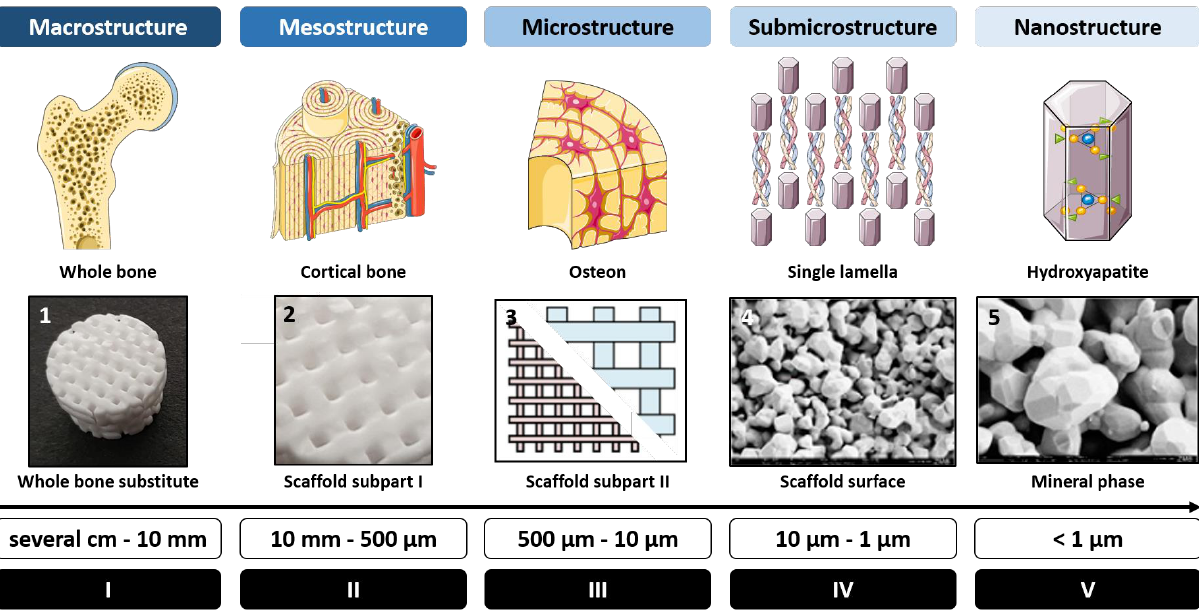
Figure 1. Five levels of hierarchical structure in native bone and bone substitute. ( I ) Macrostructure level (several cm to 10 mm), characterizing the whole bone tissue on one side or the whole bone substitute on the other side. ( II ) Mesostructure level (10 mm–0.5 mm), characterizing the cortical bone level on one side or scaffold subpart I (e.g., structure) on the other part. ( III ) Microstructure level (500 µm–10 µm), characterizing a single osteon on one side or scaffold subpart II (e.g., filament thickness) on the other side. ( IV ) Sub-microstructural level (10 µm–1 µm), characterizing the single lamella on one side and the scaffold surface (e.g., porosity) on the other side. ( V ) Nanostructure level (<1 µm), characterizing the hydroxyapatite structure on one side and the mineral phase (e.g., tricalcium phosphate) on the other side.